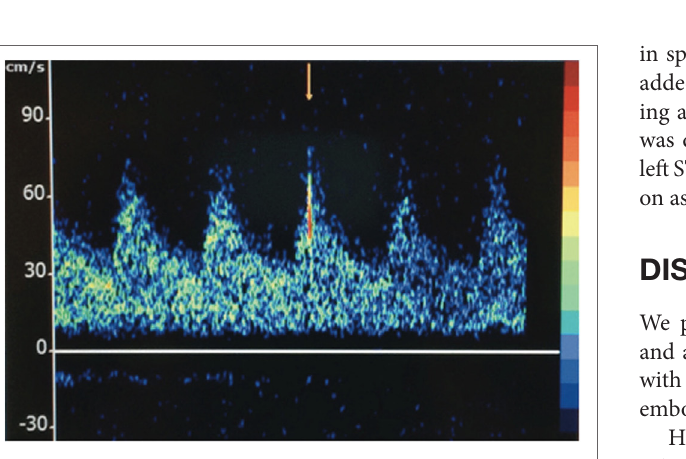
FiGURe 3 | Transcranial Doppler displaying a high-intensity transient signal (HITS) in the right middle cerebral artery territory of patient